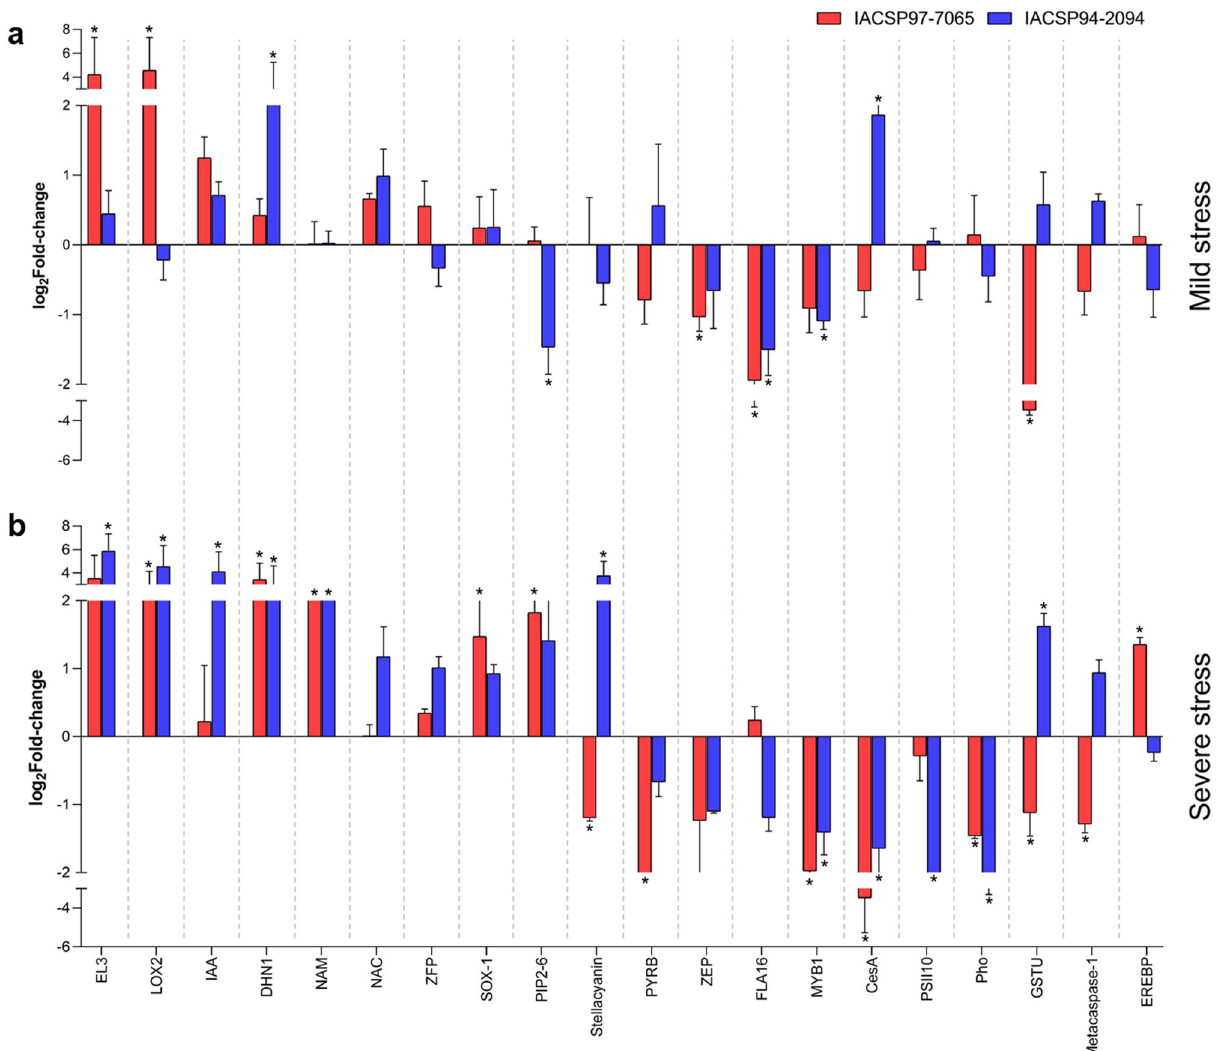
Figure 4. Gene expression validation by quantitative real-time PCR (RT-qPCR) analysis. Leaf transcriptional changes are represented as log 2 Fold-change (bars) for both sensitive (IACSP97-7065—red) and tolerant (IACSP94-2094—blue) sugarcane genotypes under ( a ) mild and ( b ) severe drought stress, compared to the respective irrigated controls. Gene symbol was based on orthology to rice ( Oryza sativa ). Error bar represents the standard deviation and the asterisk (*) indicates statistical significance ( p ≤